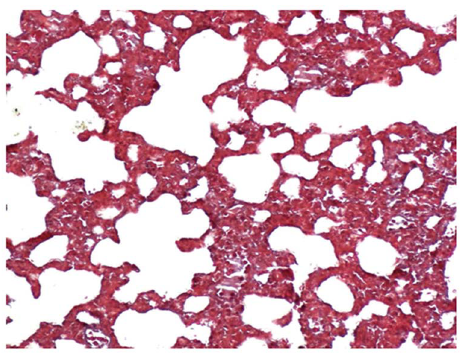
Figure 2. Masson stain of control group ( 6 200). Lung tissue is normal. The alveolar space has a normal interstitium structure, and no